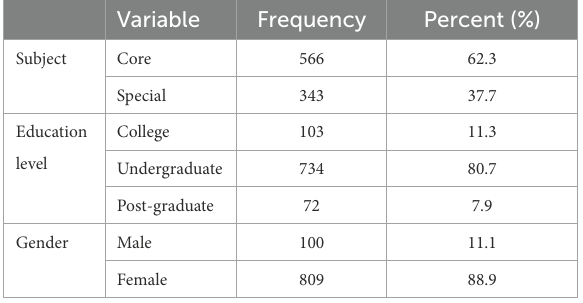
TABLE 1 Demographic characteristics of the